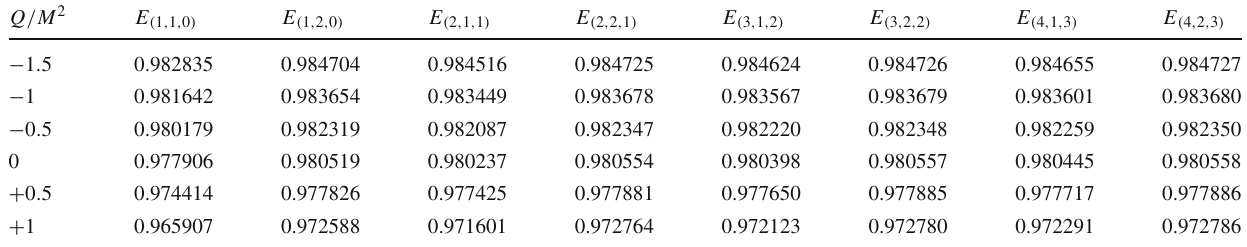
Table 2 The energy E ( z ,w,ν) for periodic orbits ( z ,w,ν) [ q = w + ν/ z ] around the DMPR brane-world black holes for different values of Q with (cid:14) = 0 .